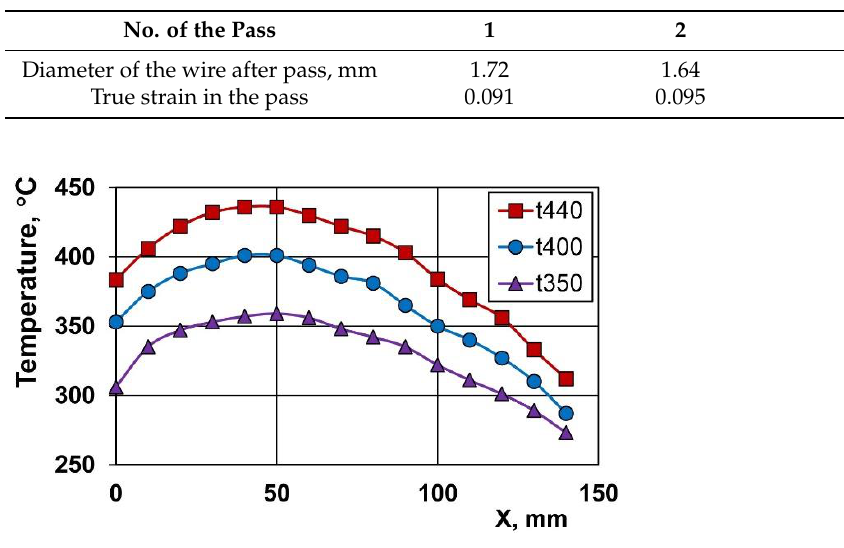
Figure 2. Temperature distribution of the wire in the furnace. Drawing direction — right to left.